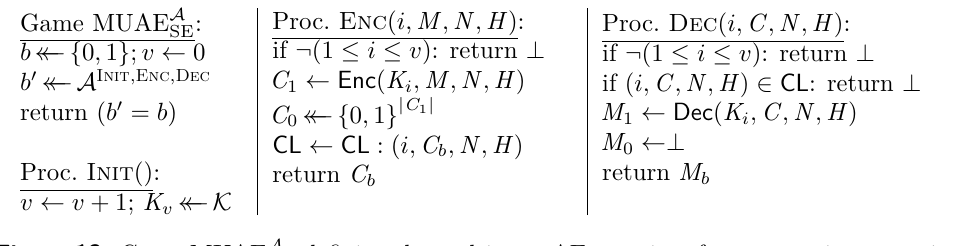
defining the multi-user AE-security of a symmetric encryption Figure 13: Game MUAE A AE scheme SE.